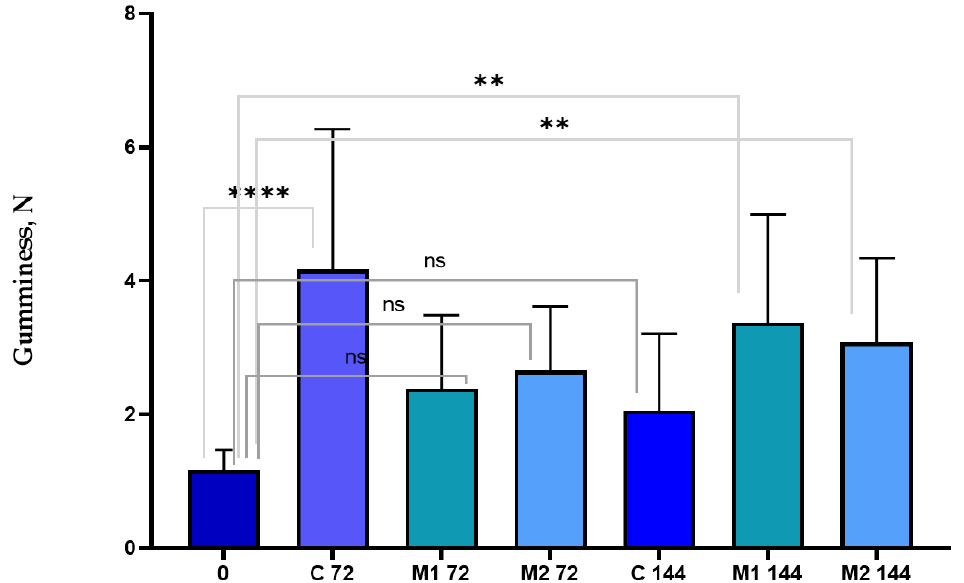
Figure 7. The gumminess of the sliced chicken sausage. ANOVA: ns—not significant; ****— p < 0.0001; **— p < 0.01.